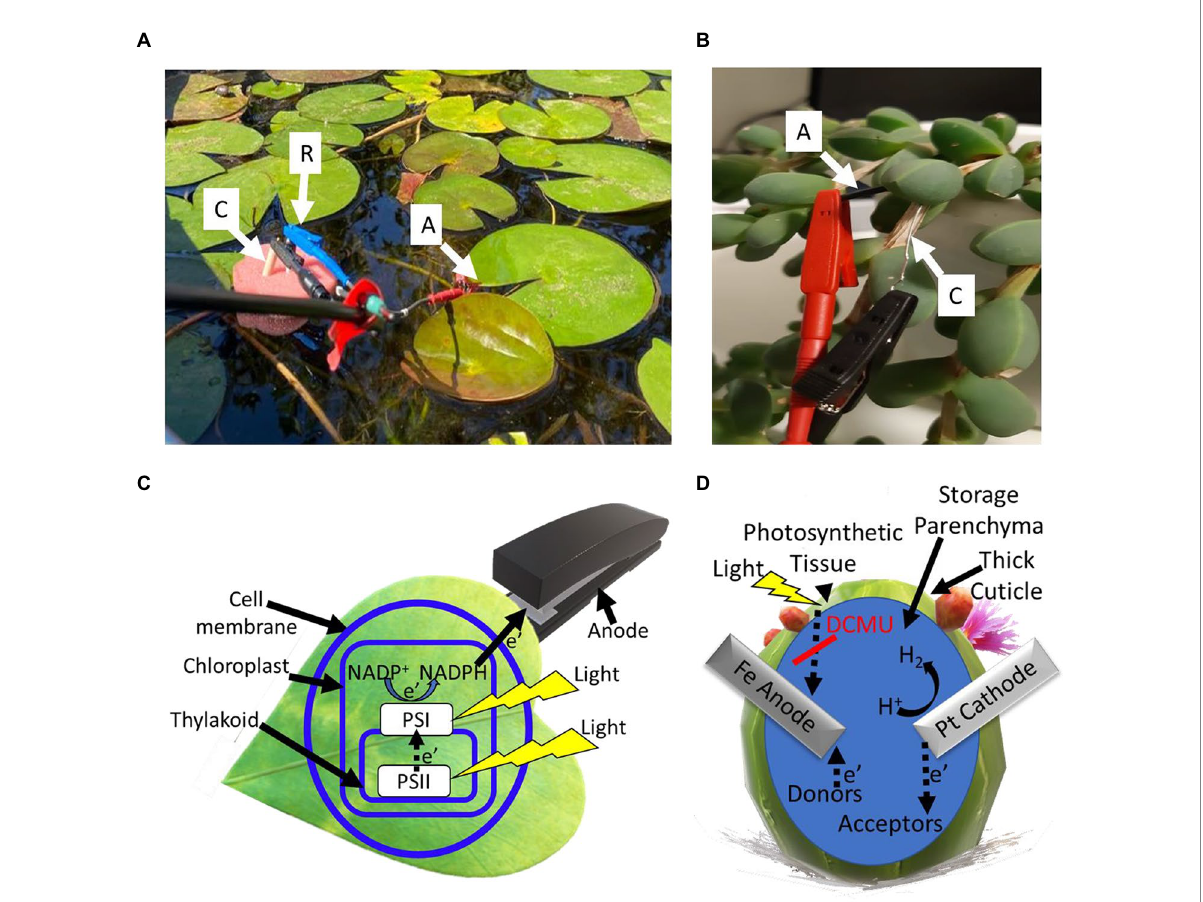
FIGURE 4 Bioelectricity production from smooth and succulent leaves. Photocurrent can be harvested from the external side of flat leaves by attaching the anode to the surface, or by insertion into the internal matrix of succulent leaves. (A) A picture showing a system for photocurrent production from waterlilies in their native habitat. A stainless-steel anode clip is connected directly to the external surface of the leaf (A). A platinum cathode (C) and an Ag/AgCl 3 M NaCl reference electrode (R) are dipped in the water of the pond, held by a floating sponge. (B) A picture showing the photocurrent production from leaves of the succulent Corpuscularia lehmannii . An iron anode (a) and a platinum cathode (c) are inserted into the internal matrix of the leaf. (C) A schematic model outlining the hypothesized electron transport pathway in the BPEC of flat leaves. Light (yellow shapes) induces photosynthesis to transfer electrons from H 2 O to PSII, PSI, and the reduction of NADP + to NADPH. A portion of the NADPH molecules withdrawals from the chloroplast (light blue rectangular), transports throughout the cell membrane and wall (light blue circle) and reduces the external anode (gray shape). (D) A schematic model for the electron transport in the BPECs based on succulent leaves. An iron anode and a platinum cathode are inserted into the leaf. Small and enhanced electric currents are produced in dark and light, respectively. The anode is being reduced by electron donors that mediate electrons from the photosynthetic system or by redox-active molecules. The addition of DCMU (red line) eliminates the light-dependent current. The platinum cathode may reduce H + ions to form H 2 gas or other biomolecules that serve as electron acceptors. The succulent leaf has a thick cuticle that functions as a native container for the